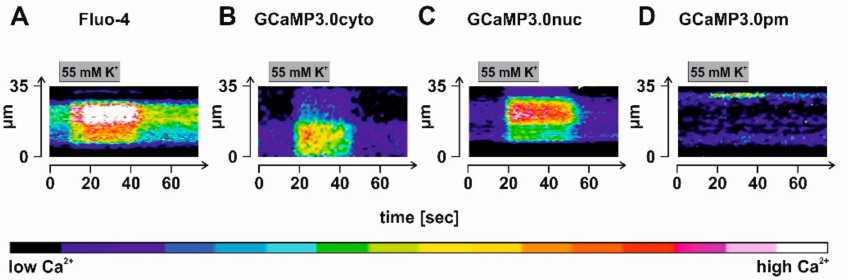
Figure 9. Detection of depolarization-evoked Ca 2+ signals in cortical neurons expressing GCaMP3.0 variants. Rat embryonal cortical neurons were incubated for eight days with recom- binant Adeno-associated virus preparations: ( B ) rAAV6-GCaMP3.0cyto, ( C ) rAAV6-GCaMP3.0nuc, and ( D ) rAAV6-GCaMP3.0pm. For control, samples were also loaded with the Ca 2+ -sensitive dye Fluo-4 ( A ). Depolarization of the membrane potential was achieved by superfusing the sample with a test solution containing a high K + concentration (55 mM) for 30 s. Depolarization-evoked Ca 2+ signals were registered in individual cells. A region of interest (ROI) along a line of 35 µ m length was defined and the fluorescence intensity for each pixel along the line was extracted and color-coded. The analysis was repeated 75 times for each image of the stimulation series, and it is depicted as a time